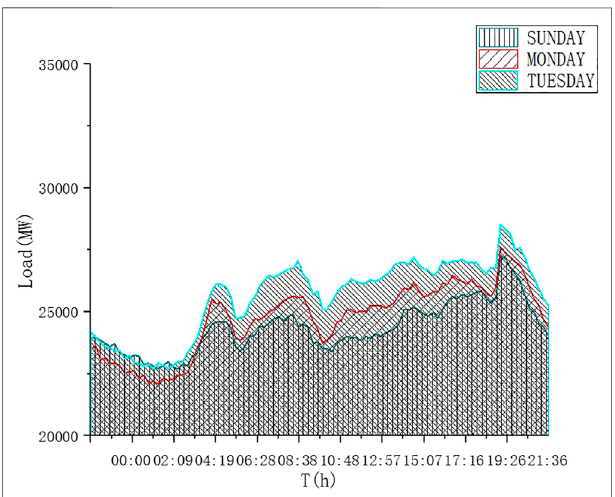
FIGURE 2 | The comparison of electricity consumption on weekends and weekdays.